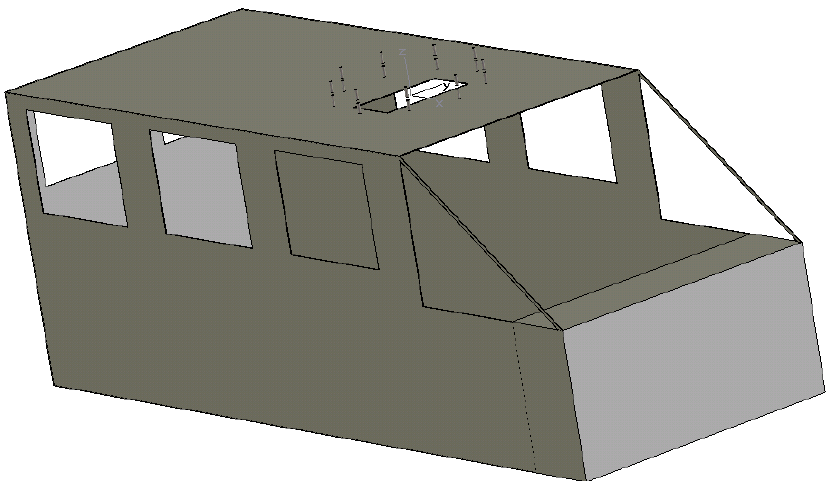
Figure 1. Model of the carrier body (minibus) with a roof hatch.